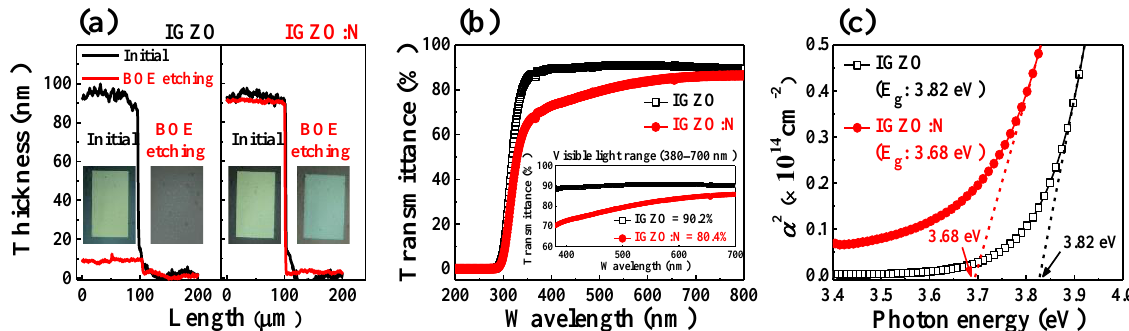
Figure 2. ( a ) Thickness of initial and buffered-oxide-etch (BOE) solution-treated IGZO and IGZO:N films. ( b ) Optical transmittance spectra (inset, optical transmittance at the visible-light wavelength region) and ( c ) optical absorption coefficients of IGZO and IGZO:N nanocomposites.